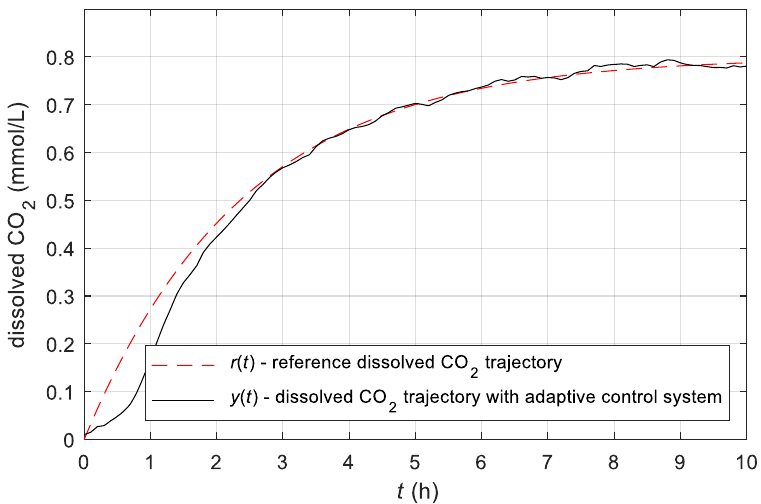
Figure 12. Time responses of the reference and actual dissolved CO 2 concentration of the modified fermentation process in the batch bioreactor; simple adaptive control was used; data of the controlled modified fermentation process with inactivated kefir grains are shown in Table 3, the adaptation mechanism parameters in (23) and (24).